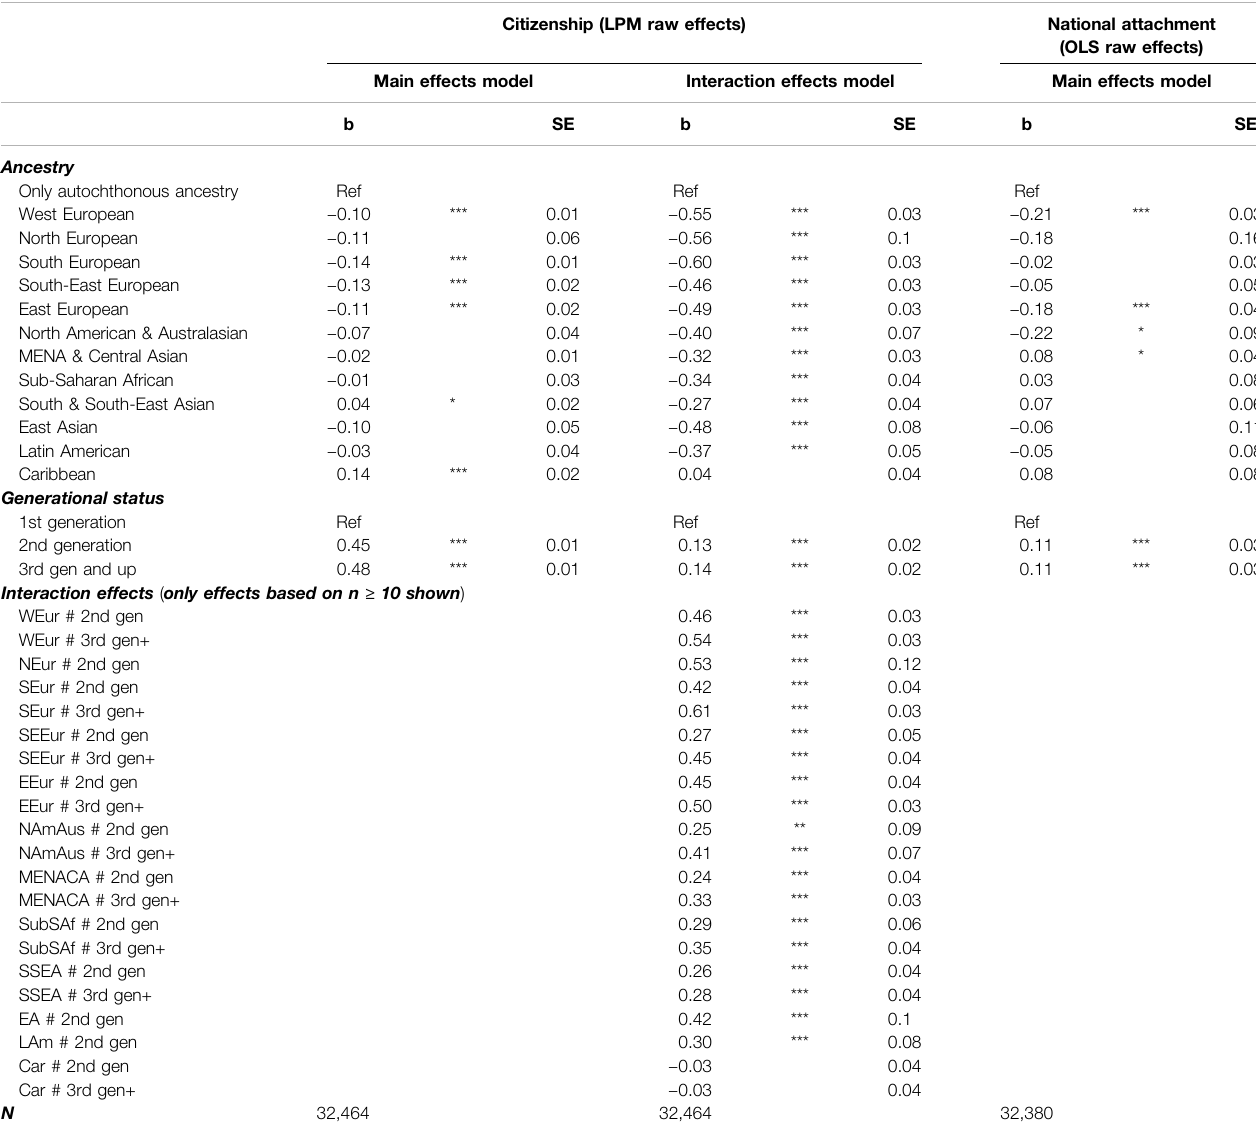
TABLE 9 | Regression models for civic